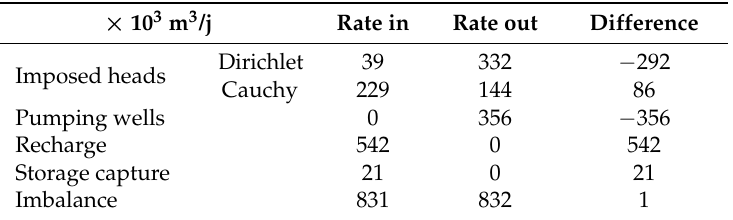
Figure 8. Piezometric map simulated under steady-state conditions in the reference year (1978). Table 2. Imbalance of the contributions calculated in